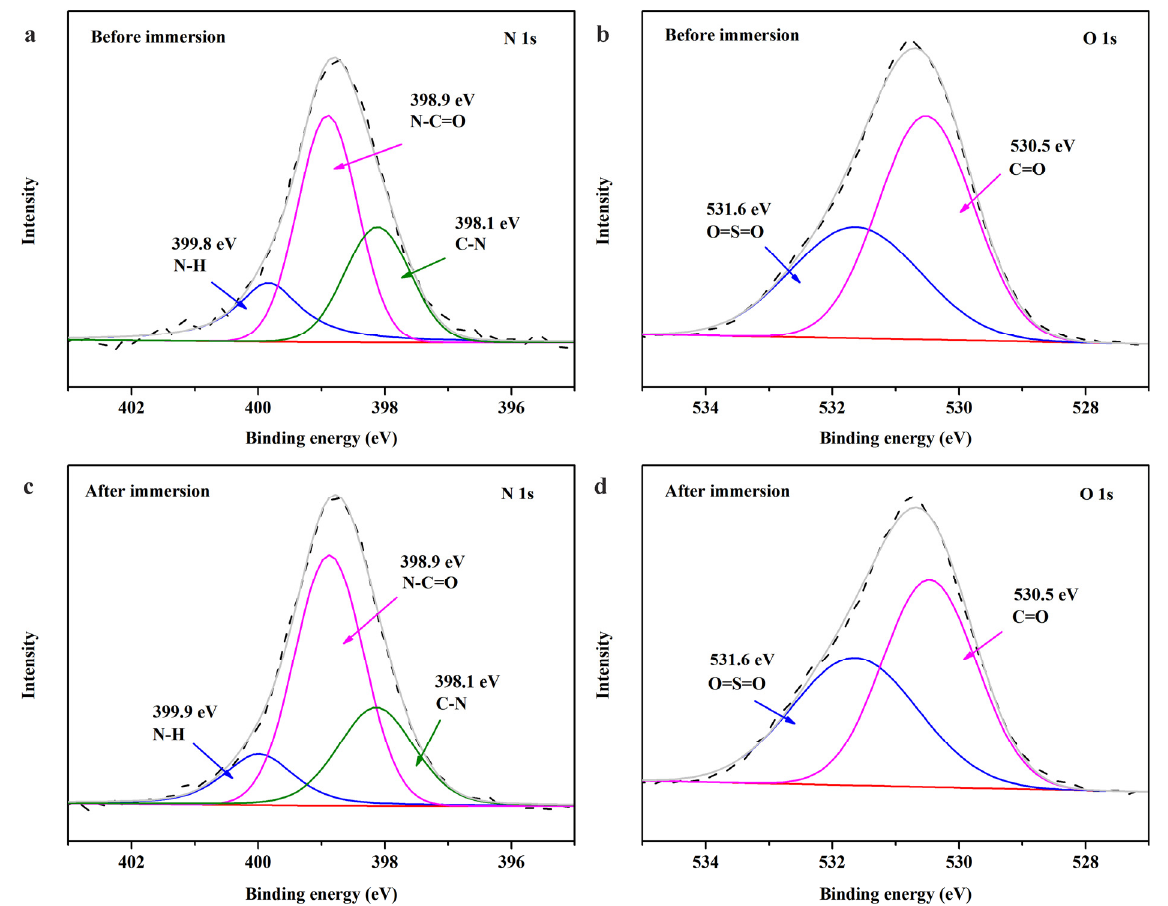
Figure 17. FTIR spectra of PES–DPS–1 before and after chlorine immersion (Blue dashed lines are intended to help locate the corresponding absorption peak).